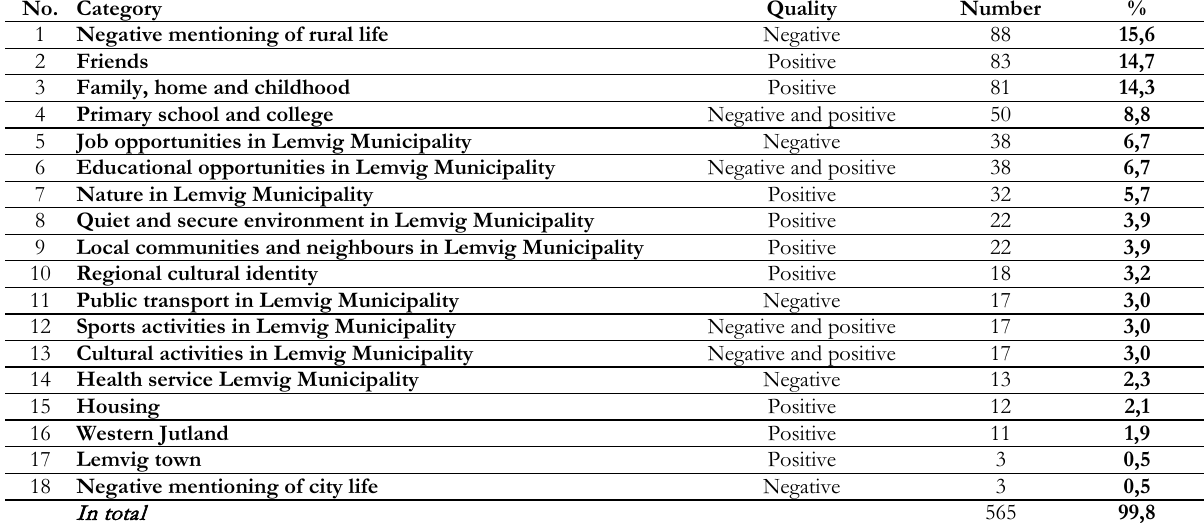
Table 2. Answers from interviews with 25 young outmigrants, divided into 18 main categories, in total 565 words. November 2012. NVivo